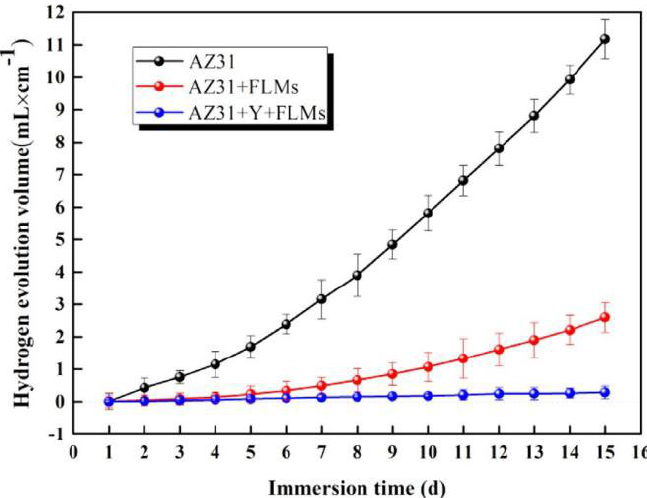
Figure 51. Images of hydrogen evolution volume for bare AZ31, AZ231 + FLMs and AZ31 + Y + FLMs before and after being immersed in 3.5 wt.% NaCl solution for 15 days. Reprinted with permission from [86]. Copyright 2021 Elsevier.